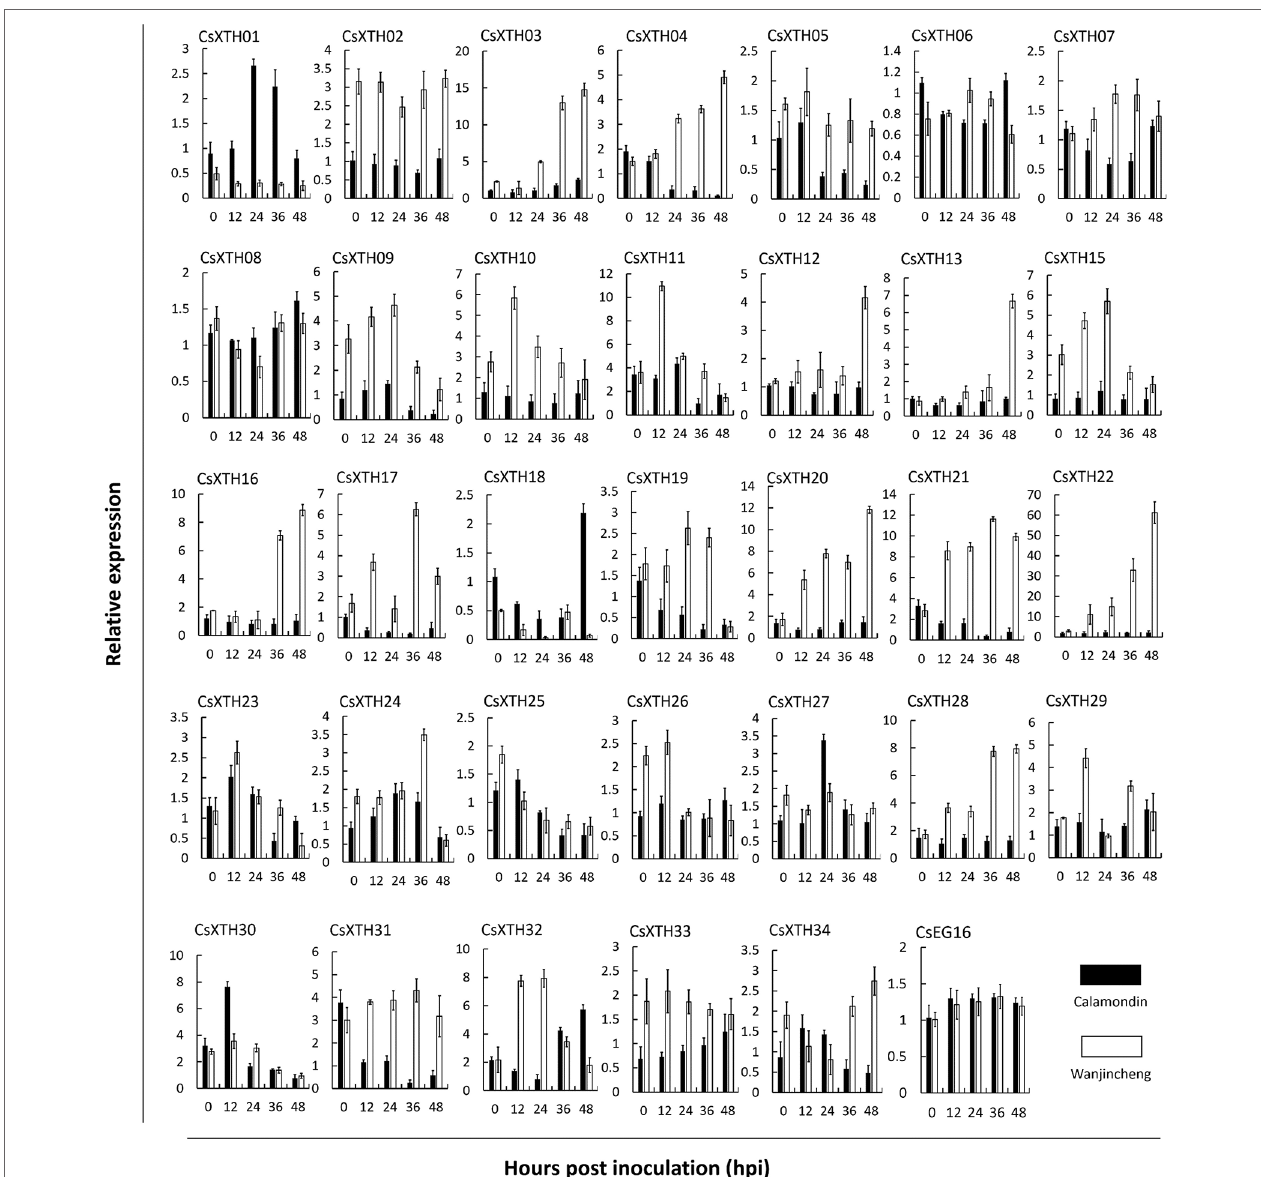
FIGURE 3 | Differential expression profiles of CsXTHs induced by Xcc. Samples for expression profiling were collected from Wanjincheng (empty bars) and calamondin (solid bars) at 0, 12, 24, 36, and 48 h post inoculation (hpi) of Xcc. Expression profiles were detected by qRT–PCR and normalized to CsActin. Control samples were inoculated with LB medium. Note that the relative expression of CsXTHs was on a different scale. LB, lysogeny broth; qRT–PCR, quantitative reverse transcriptase–polymerase chain reaction; Xcc, Xanthomonas citri subsp. citri